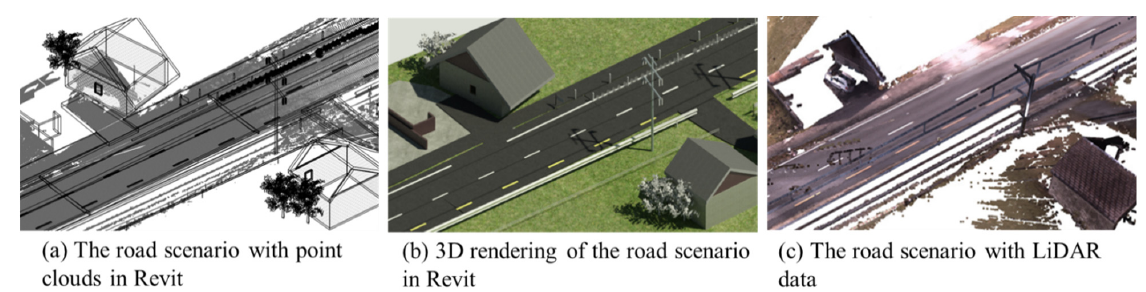
Figure 16. Comparison of LiDAR data and the digital road scenario.